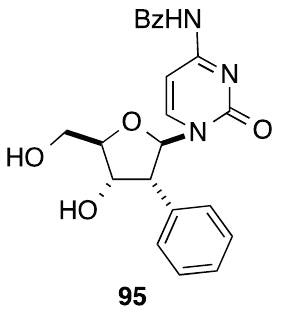
Figure 5. (2( R )- C -Phenylribofuranosyl)cytosine derivative 95